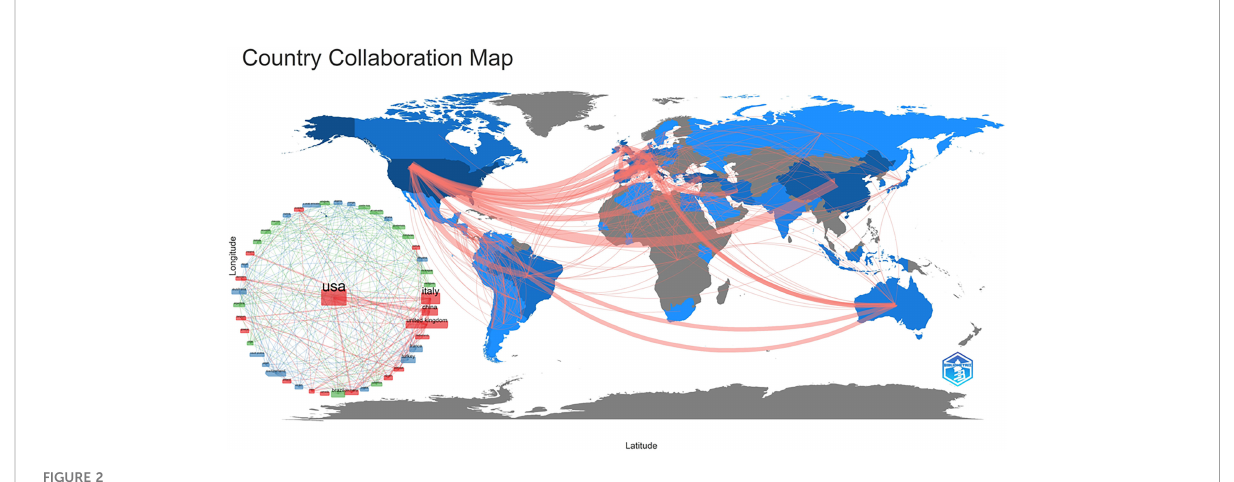
FIGURE 2 The country collaborative map in the fi eld of